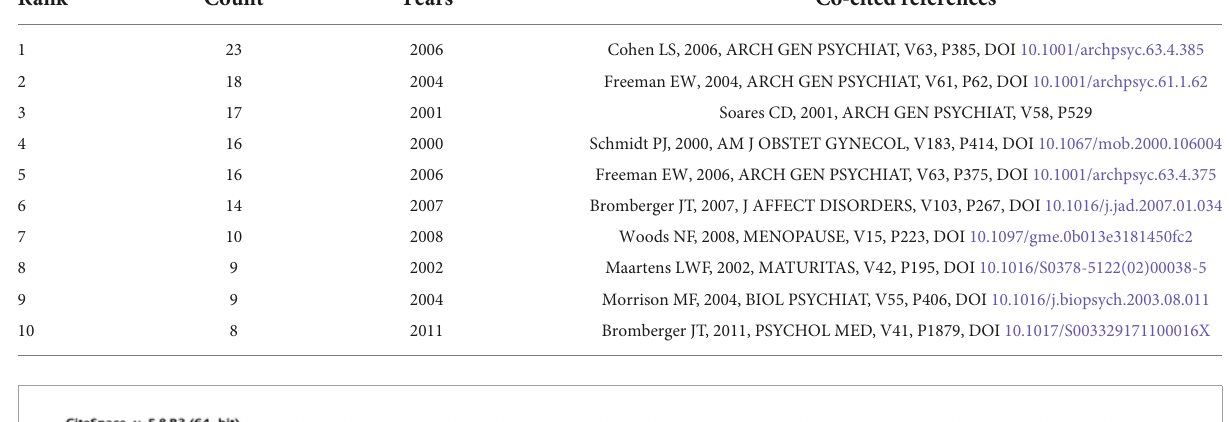
TABLE 5 Top 10 co-cited references related to PMD in counts.